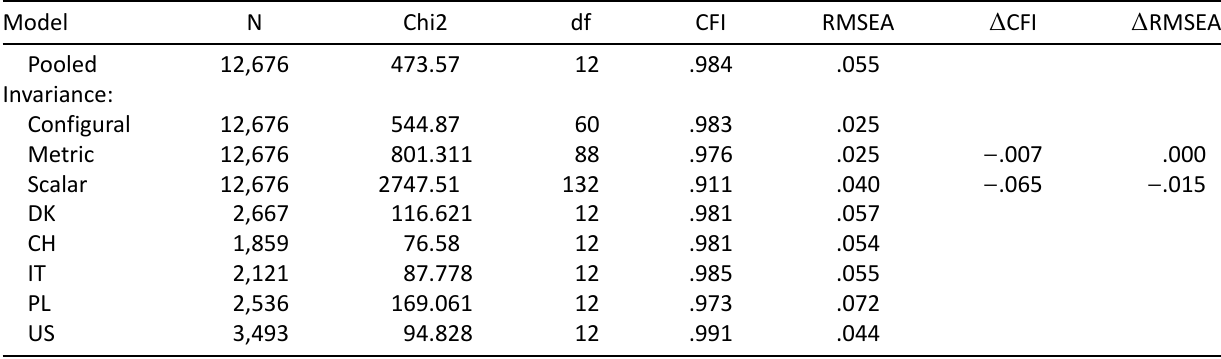
Table 2. Model fit indices for different steps to determine measurement invariance.